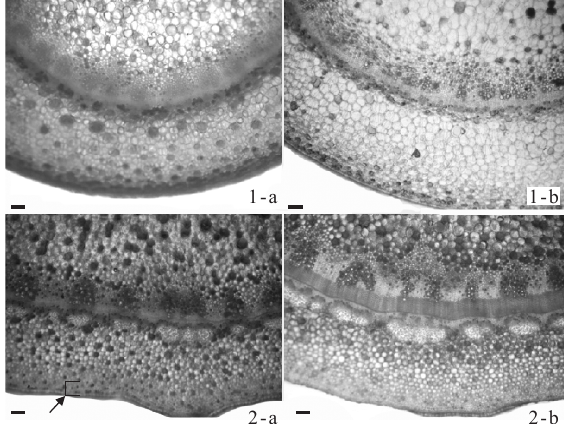
Fig. 4 - Anatomical cross sections of stems of Kalanchoe brasiliensis seedlings (1-a: under full sunlight; 1-b: 25% of light) and Kalanchoe pinnata (2-a: under full sunlight; 2-b: 25% of light). Arrow: Detail of subepidermal collenchyma in Kalanchoe pinnata . Bars = 0.1mm.